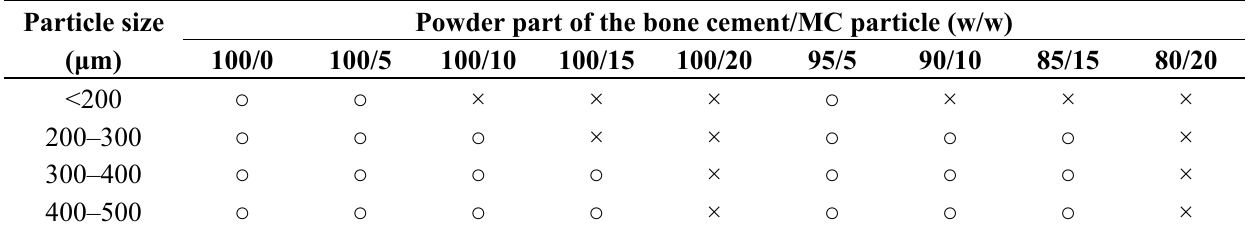
Table 3. The injectability of the MC modified Spineplex™ bone cement.